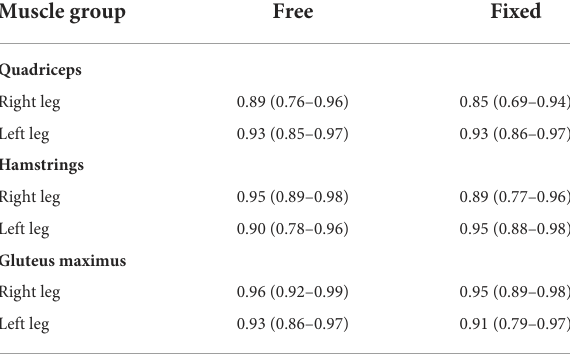
TABLE 3 Within-session reliability of the EMG data for both squat conditions (free or fixed barbell movement path), all muscle groups and each